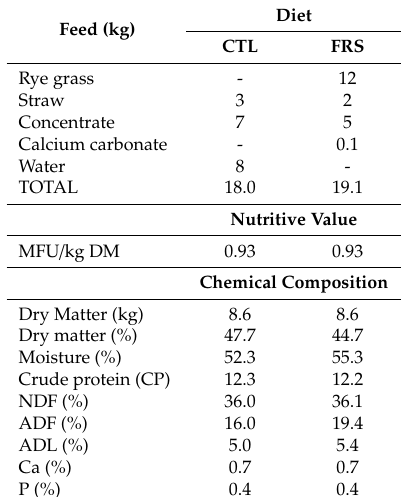
Table 1. Feed (kg) and chemical composition (% of dry matter, DM) of the diet in bu ff aloes with (FRS) or without (CTL) rye grass inclusion.